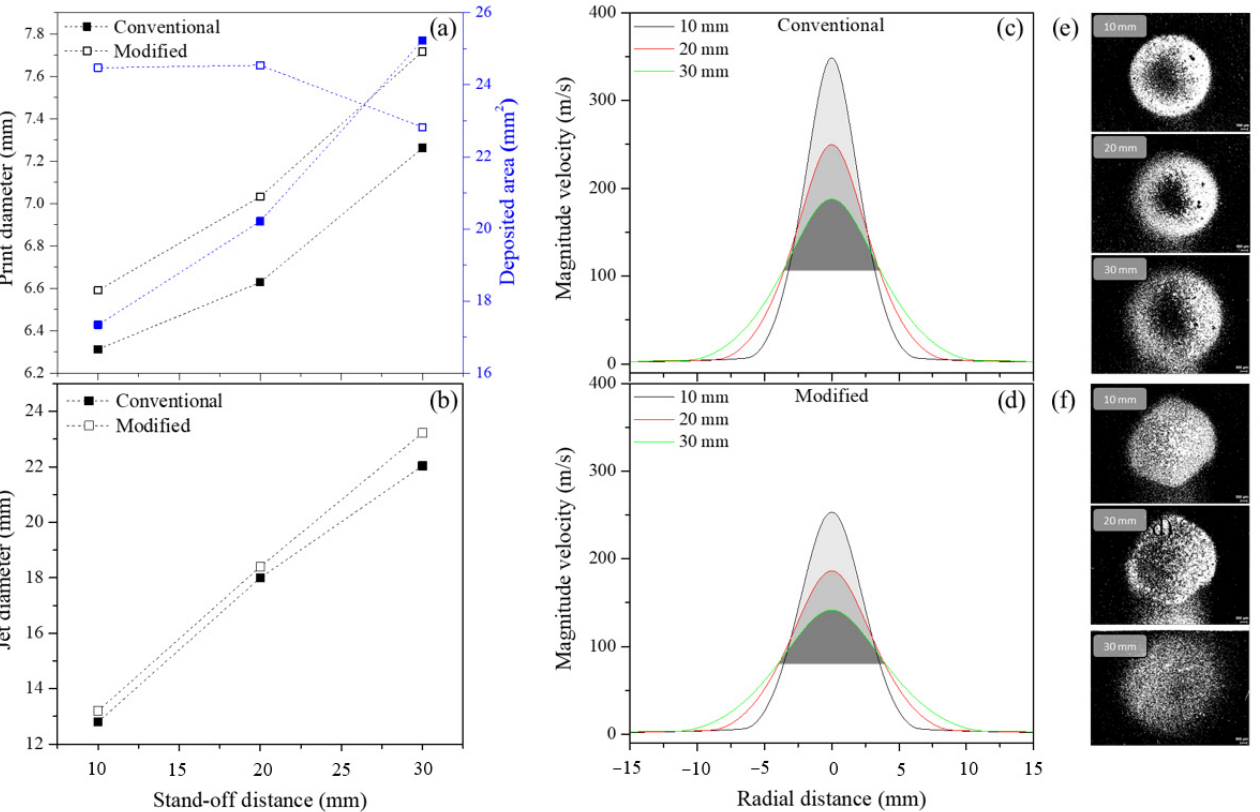
Figure 4. Summary of the footprints and jet diameters: ( a ) experimental footprint diameter and deposited area, ( b ) jet diameter obtained with CFD, jet velocity profile using the ( c ) conventional and ( d ) modified nozzles. Optical micrographs of the footprints are shown in ( e ) for the conventional nozzle and ( f ) for the modified nozzle.